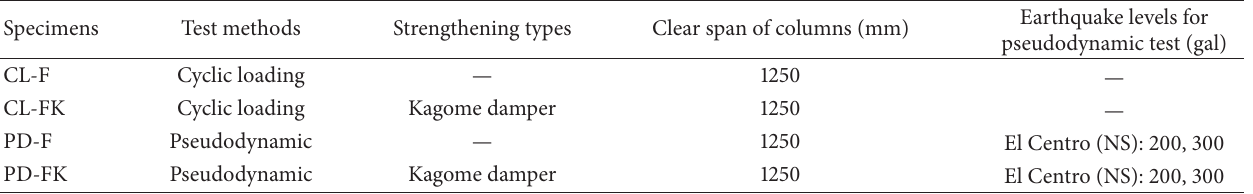
Table 4: Summary of the test conditions for the cyclic loading and pseudodynamic